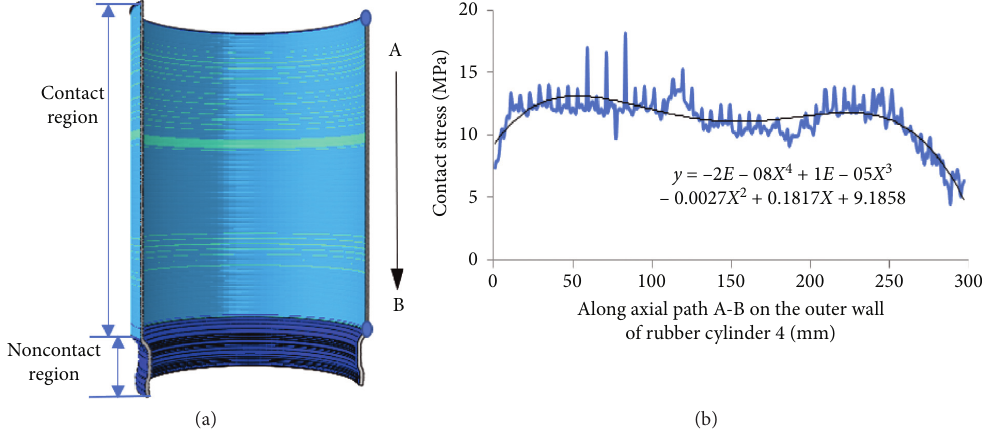
Figure 14: Contact stress variation in the rubber cylinder 4 and the average contact stress along the axial path on the outer wall of the rubber cylinder during the expansion.